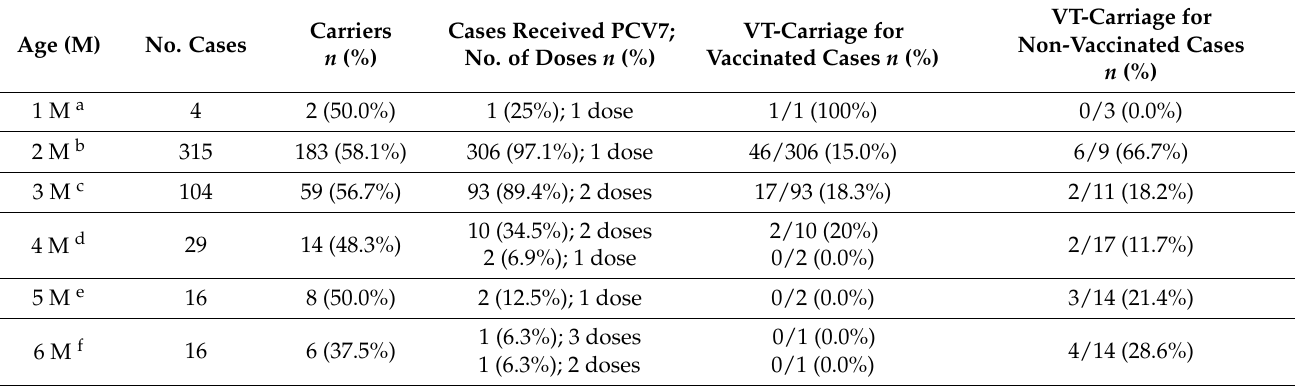
Table 1. Rate of pneumococcal carriage with VT-carriage for vaccinated and non-vaccinated infants, including number of PCV7 injections in each age